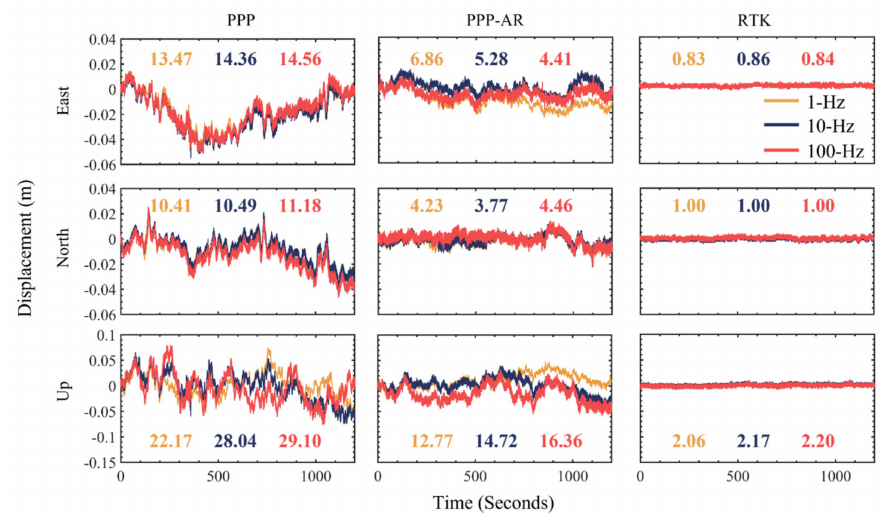
Figure 12. Three-dimensional displacement time series from multi-GNSS data of 100-, 10-, and 1-Hz, respectively, and PPP, PPP-AR, and RTK techniques. The upper, middle, and lower panels represent displacements in the East, North, and Up directions, respectively, while the left, middle, and right columns represent results from PPP, PPP-AR, and RTK, respectively. The standard deviation (in mm) of each time series is given in the corresponding color (Starting from 07:25:00 GPST).